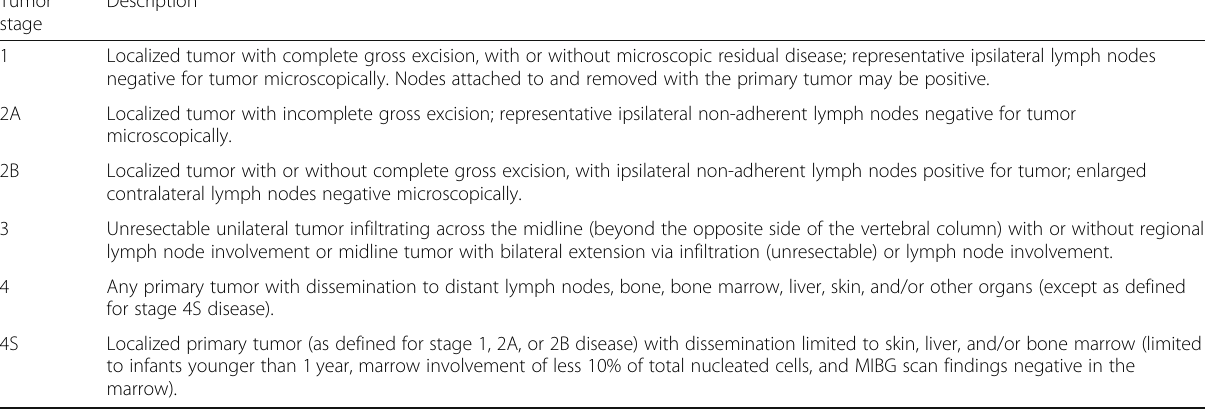
Table 1 Descriptions of original INSS tumor stages [6] Tumor stage